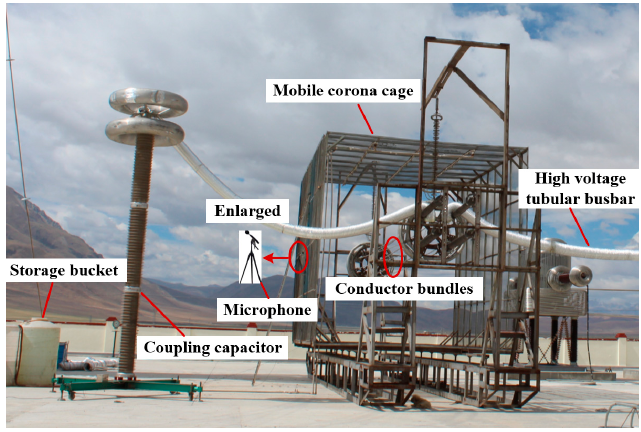
Figure 1. Mobile corona cage at Yangbajain (4300 m elevation).